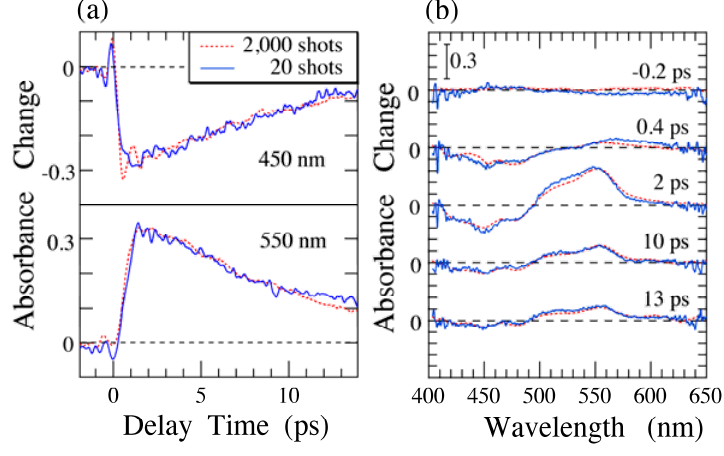
Figure 5. (a) Temporal evolution of the absorbance changes at 450 and 550 nm, and (b) time-resolved absorbance change spectra with different delay times reproduced by the 2D images shown in Figure 4